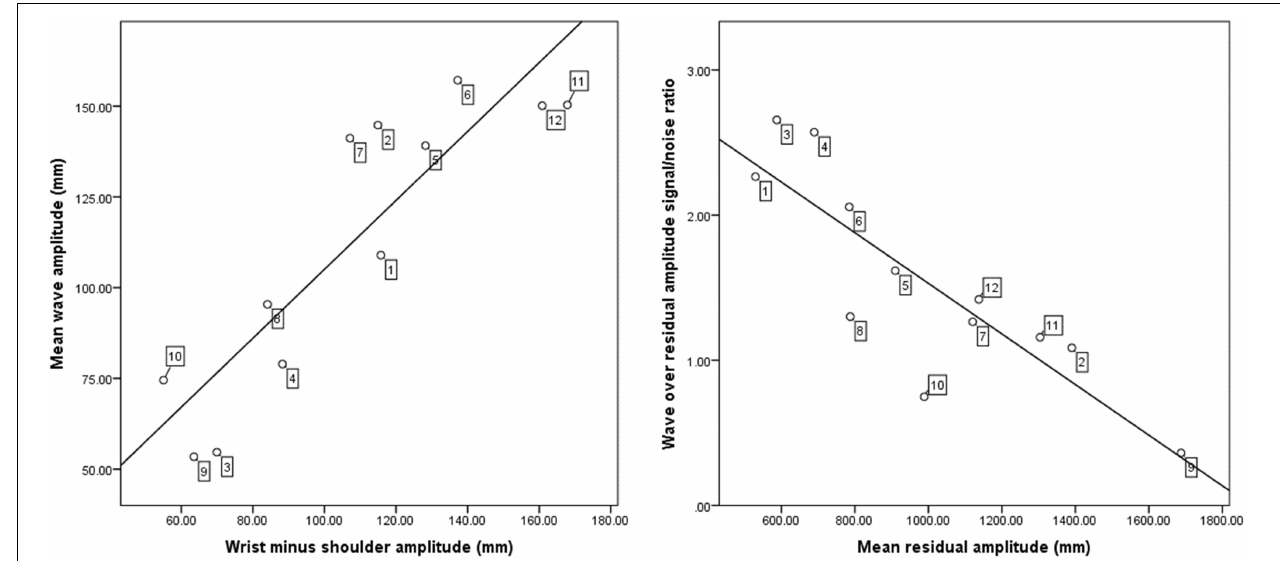
FIGURE 5 | Scatter plot on the left reveals the relationship between the wave amplitude and the wrist minus the shoulder amplitude. The scatter plot on the right reveals the relationship between the residual amplitude and the signal to noise ratio of wave amplitude over the residual amplitude. The numbers anchored to the data points along the regression line denote the individual participants designation (e.g., 10 = participant 10). The position of participant designation denotes from top-left to bottom-right in the graph the ranking of more successful to least successful